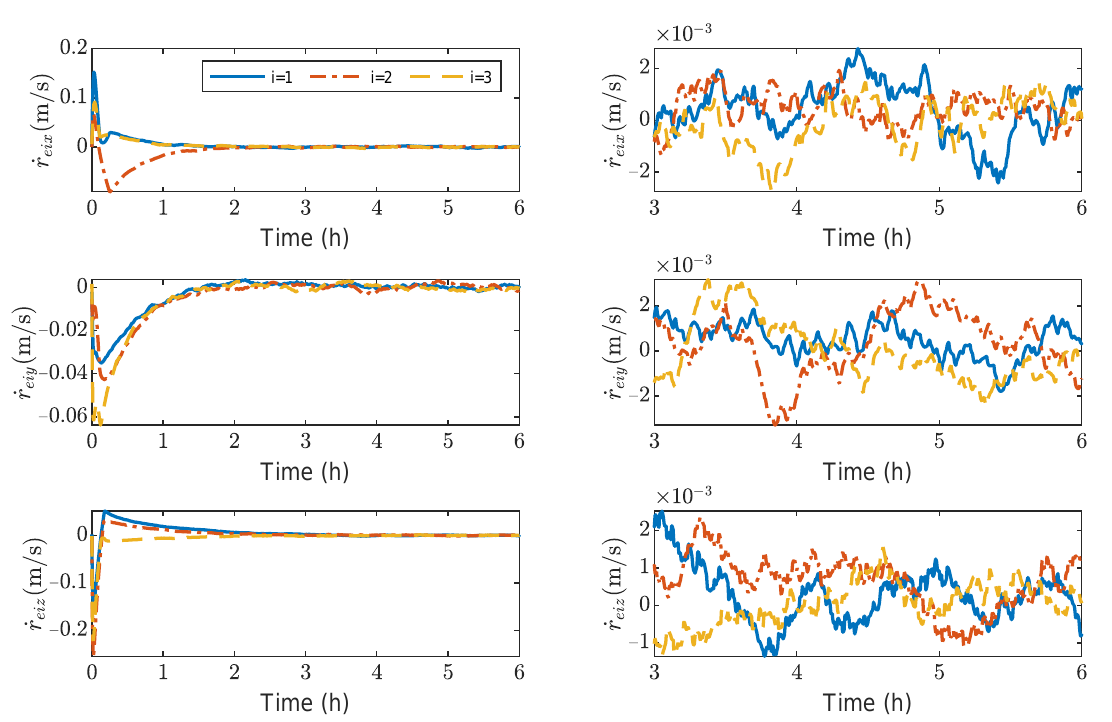
Figure 14. Relative linear velocity errors of spacecraft SC1 ∼ 3, the max control force of spacecraft is 100